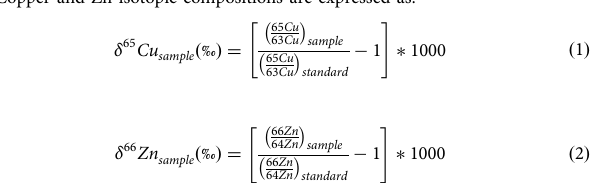
interval, or the VO 2 reaches a clear plateau. Liver mitochondrial complex I and IV activity (Mitosciences, Eugene, OR, USA), citrate synthase (Sigma) were deter- mined according to the manufacturer ’ s protocols. Liver and muscle ROS were determined by 4-HNE detection in PBS tissue lysates using an ELISA-based method (Cell Biolabs, San Diego, CA, USA).